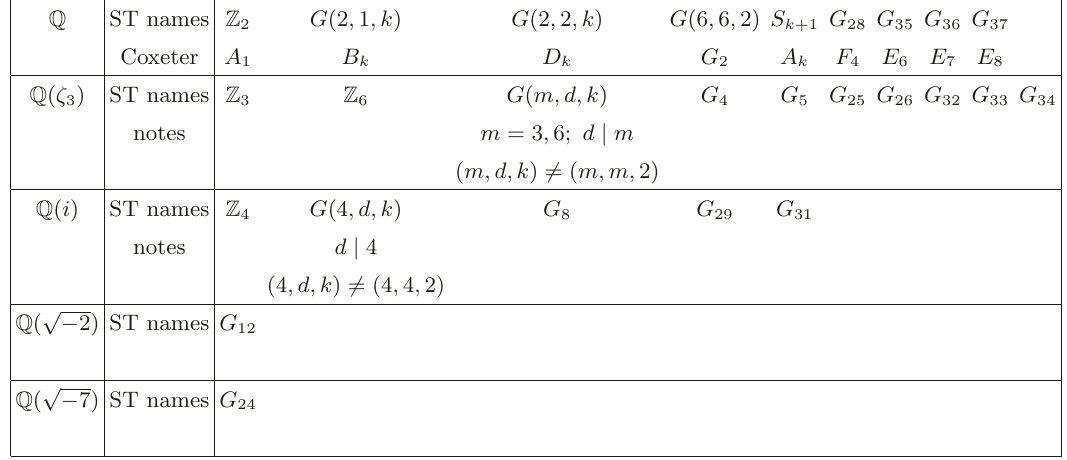
Table 3 . The Shephard-Todd irriducible complex cristallographic groups; ζ 3 stands for a primitive third root of 1. The excluded cases are G (3 , 3 , 2) which is conjugate in U(2) to Weyl( B 2